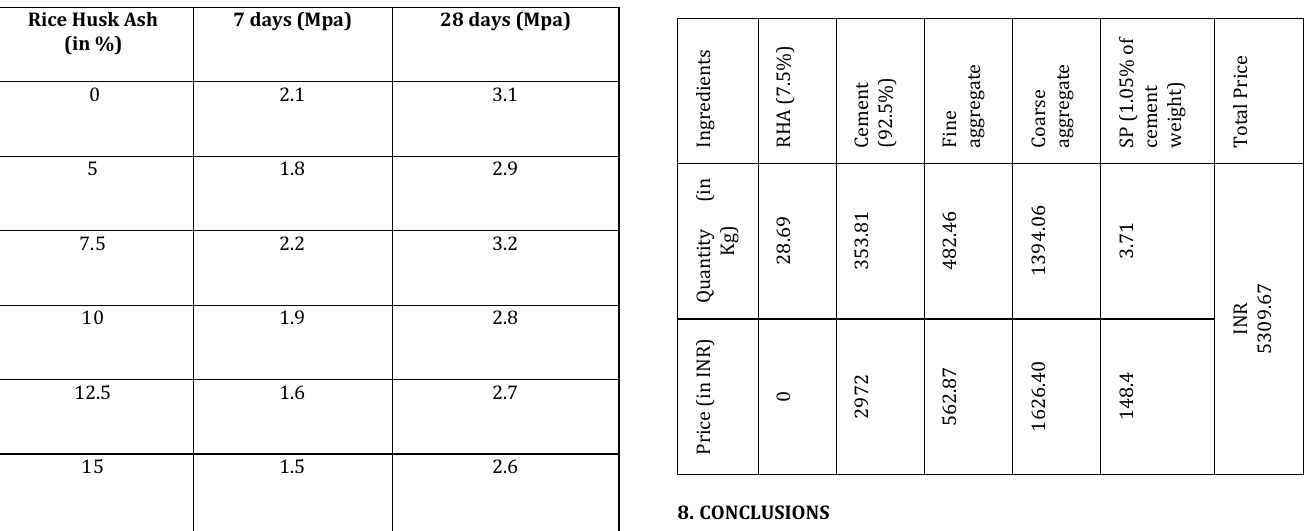
Table 10: ( price details of M-40 mix for 1m 3 concrete with